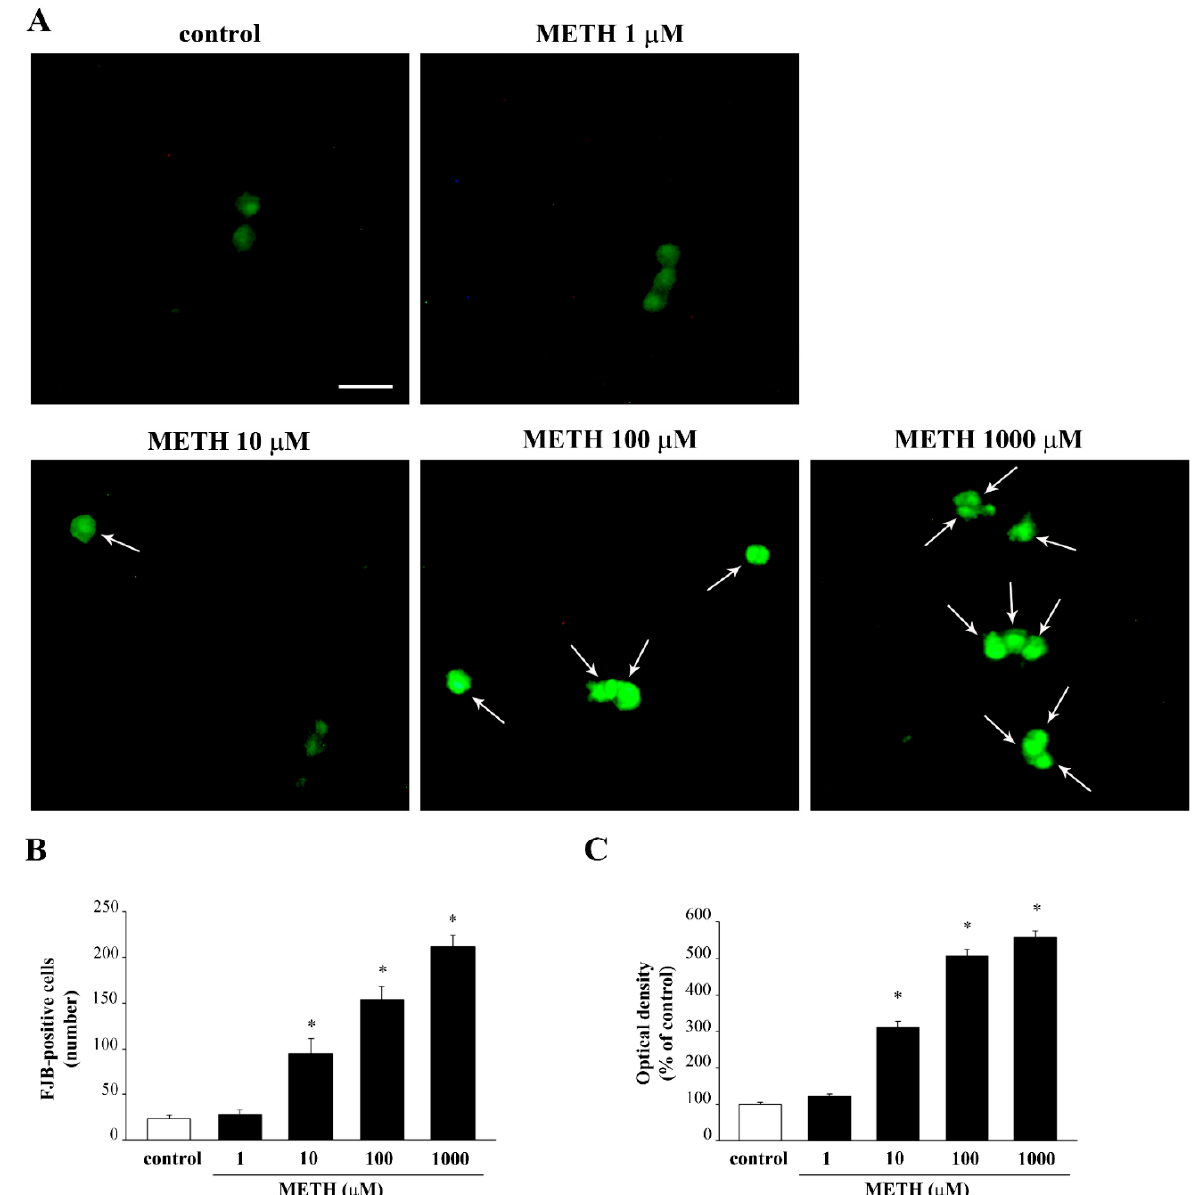
Figure 8. Dose-dependent Fluoro-Jade B-responsiveness of PC12 cells after METH exposure. ( A ) Representative pictures of FJB-stained PC12 cells after METH administration ranging from 1 µ M up to 1000 µ M for 72 h. The graphs shows the number ( B ) and intensity ( C ) of FJB fluorescent cells (arrows). * p ≤ 0.05 compared with control. Scale bar = 17.1 µ M.